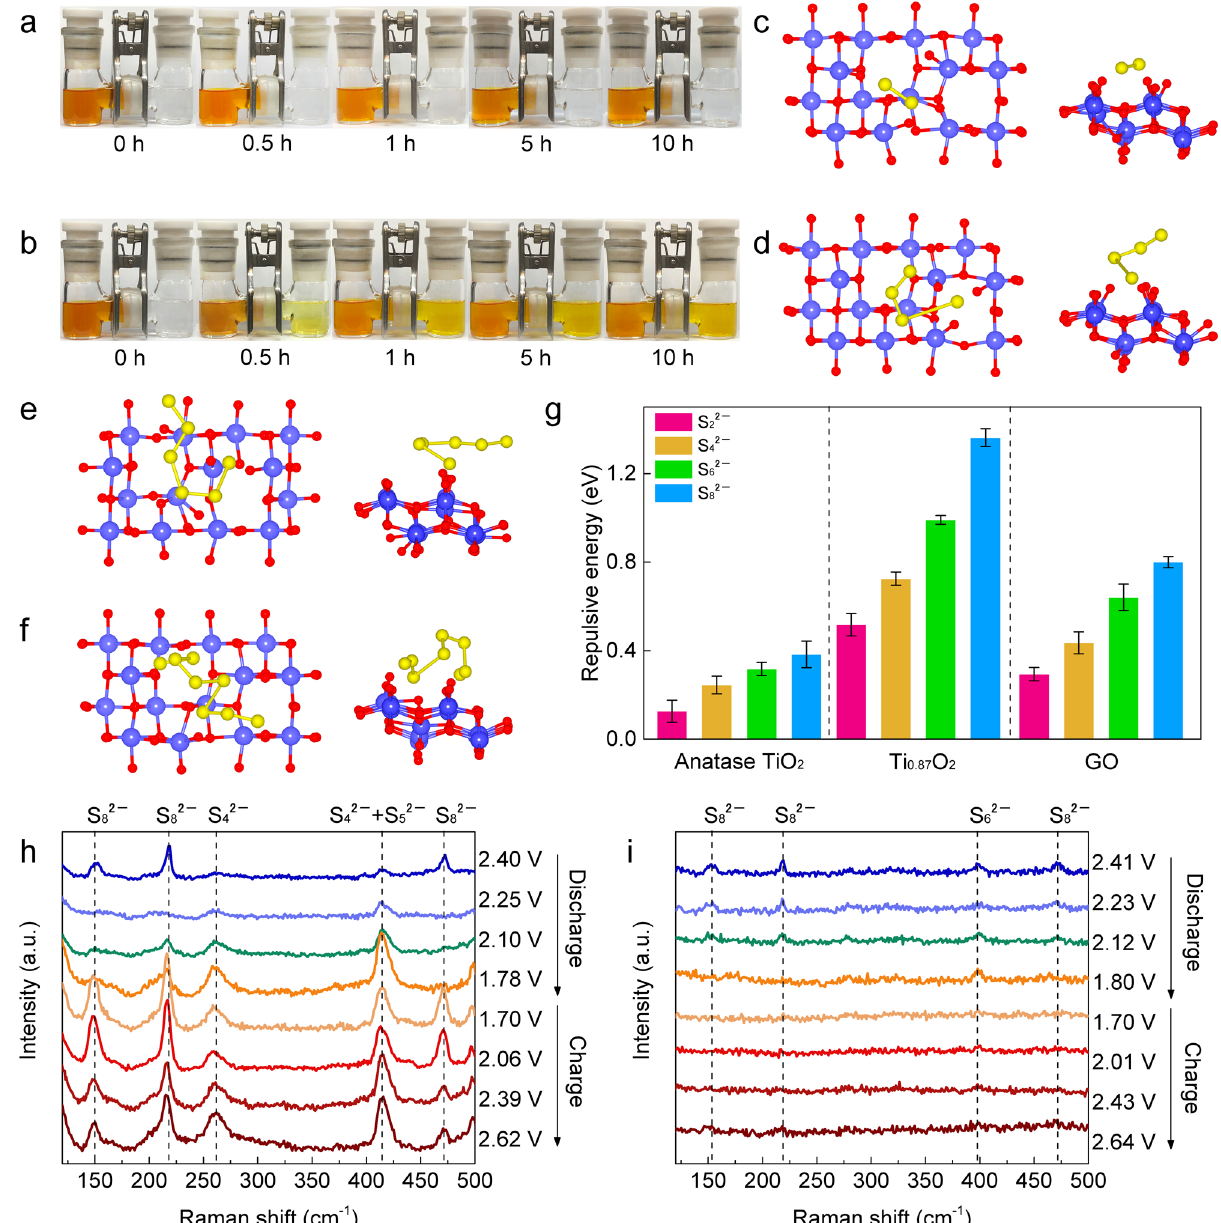
Fig. 5 Polysul fi de shuttling suppression capability for the Ti 0.87 O 2 /PP separator. Polysul fi de permeation measurements in H-type cells with ( a ) Ti 0.87 O 2 /PP and ( b ) bare PP separators. Optimized conformations of ( c ) S 2 2 − , ( d ) S 4 2 − , ( e ) S 6 2 − and ( f ) S 8 2 − on the Ti 0.87 O 2 sheet. g Repulsion energies of various polysul fi de S x 2 − on anatase TiO 2 , GO, and Ti 0.87 O 2 . Error bars were included, which represent the standard deviation of the data taken from fi ve optimized con fi gurations. Raman spectra obtained for ex situ samples harvested from cycled cells during the discharge and charge processes in Li-S cells with ( h ) PP and ( i ) Ti 0.87 O 2 /PP